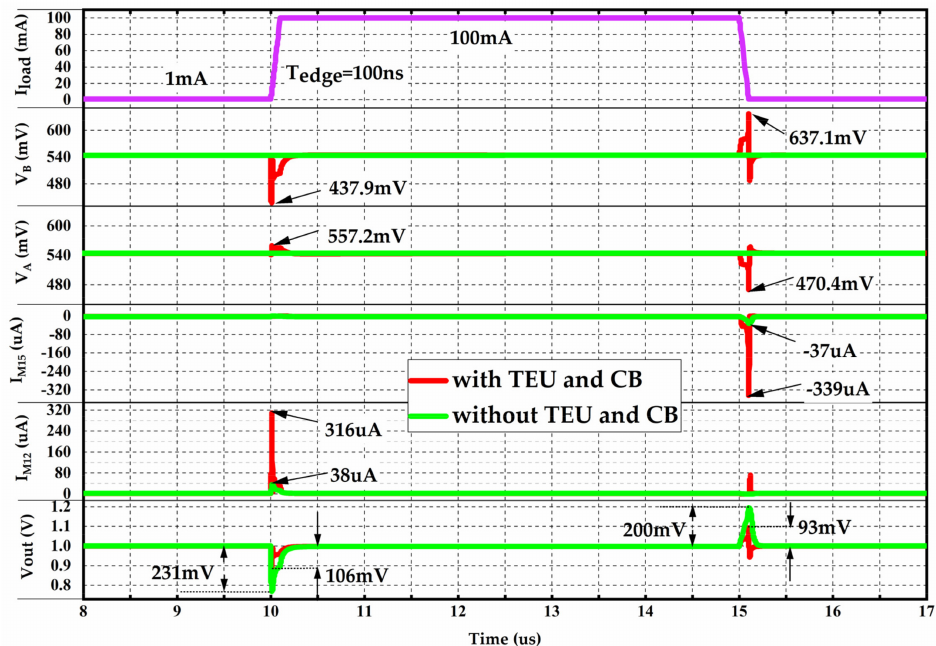
Figure 13. Simulated load transient response of the OCL–LDO with/without TEU and CB.